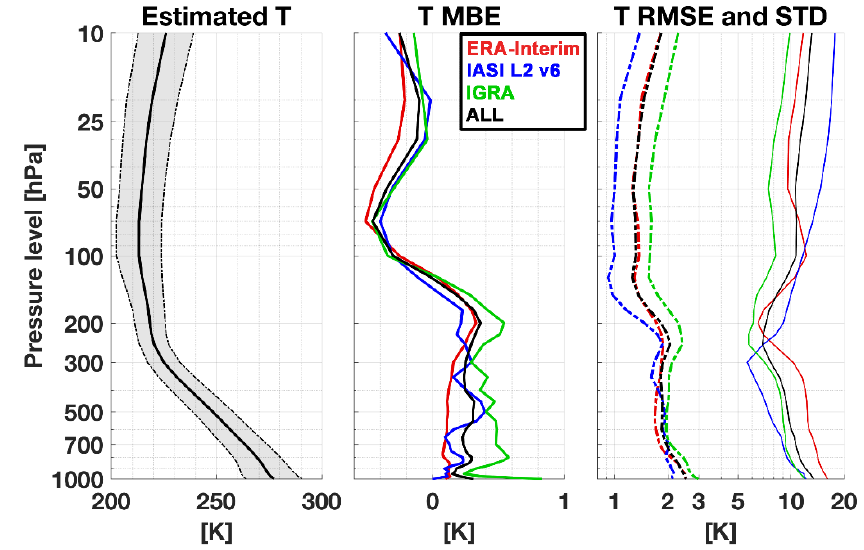
Figure 7. Left : Estimated profile of T mean (solid) and standard deviation (STD) (shaded) for 2017. Center: profiles of the corresponding mean bias error (MBE). Right : profiles of the corresponding RMSE (dashed lines) compared with STD (solid lines).